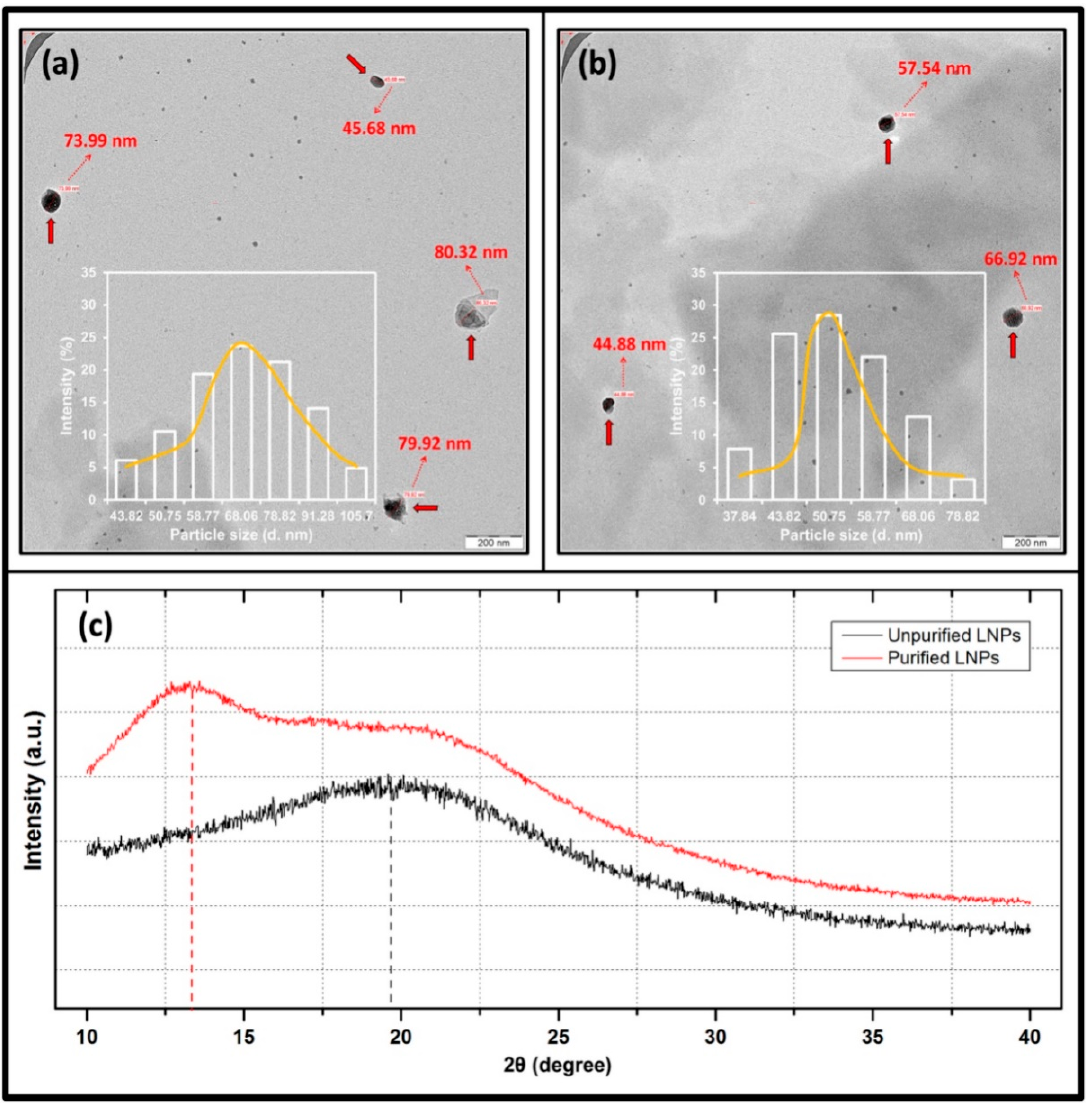
Figure 1. TEM micrograph and particle size distribution of ( a ) unpurified LNPs and ( b ) purified LNPs, and ( c ) XRD patterns of unpurified and purified LNPs.